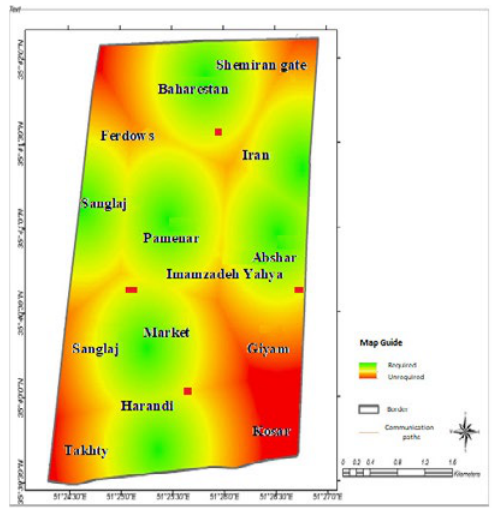
Fig. 13: Fuzzy distance layer from crisis management centers in district 12 of Tehran Fig. 14: Fuzzy distance layer from health centers in the District 12 of Tehran